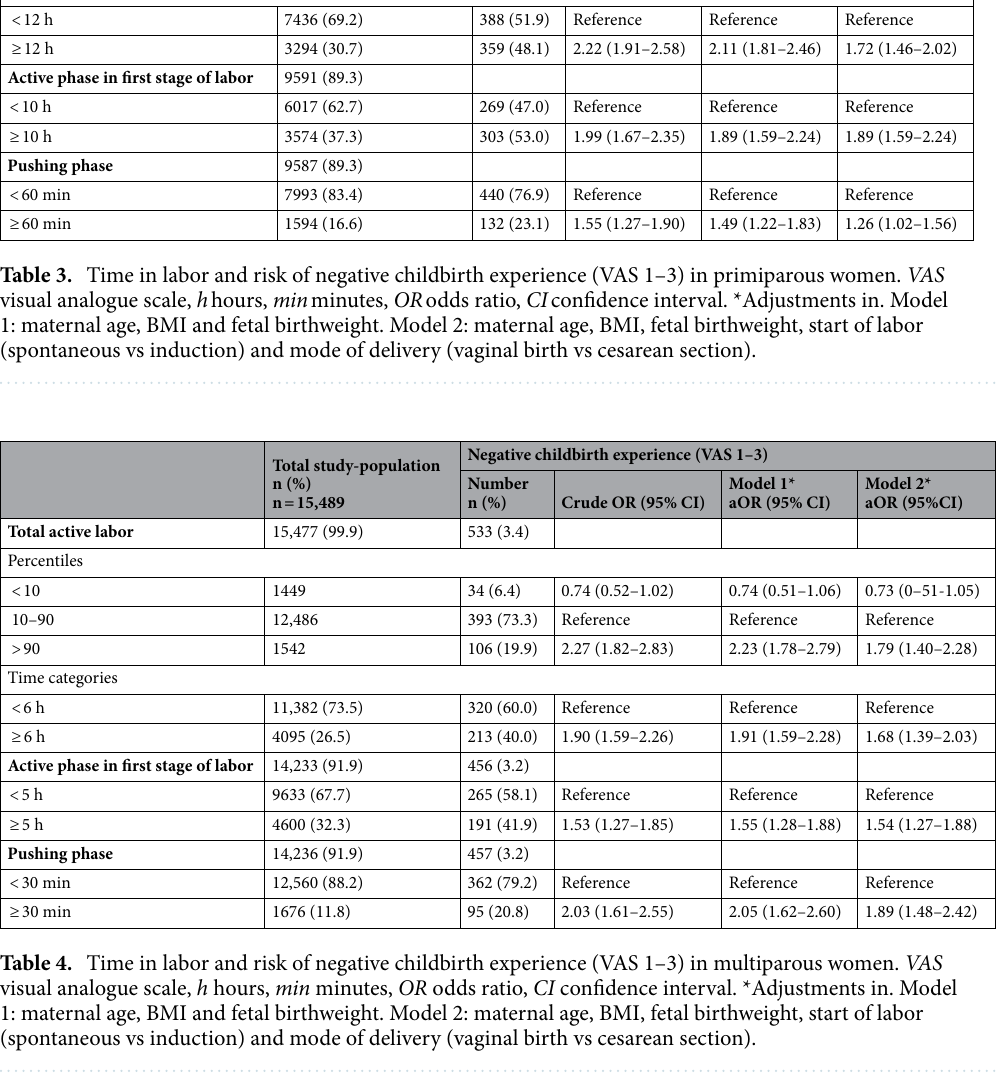
(Table S4). For primi- and multiparous women delivered with CS, no statistically significant differences were seen (Tables S3, S4). Discussion